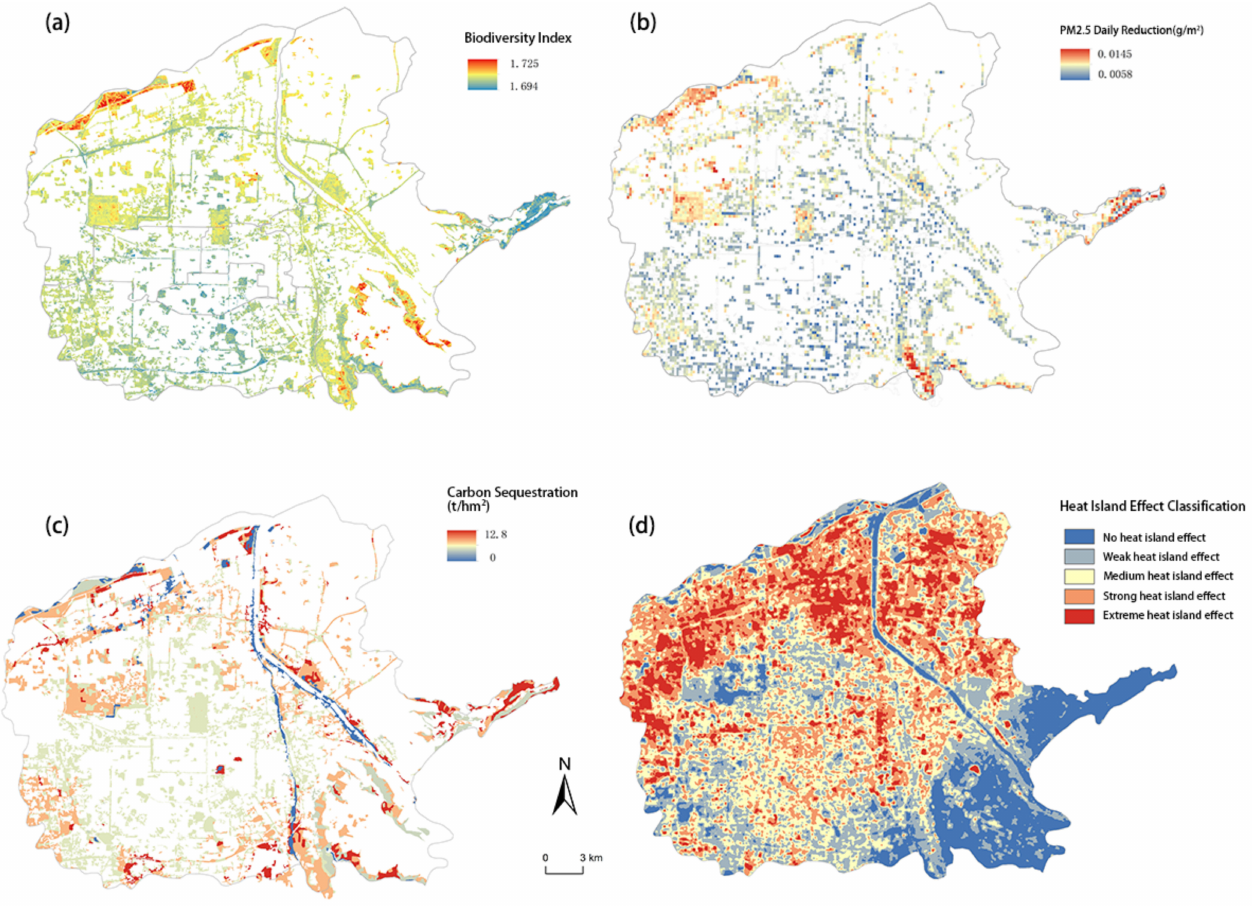
Figure 3. Evaluation of ecosystem services in urban green spaces. ( a ) Biodiversity map. ( b ) PM2.5 daily Reduction map. ( c ) Carbon sequestration map. ( d ) Heat island effect